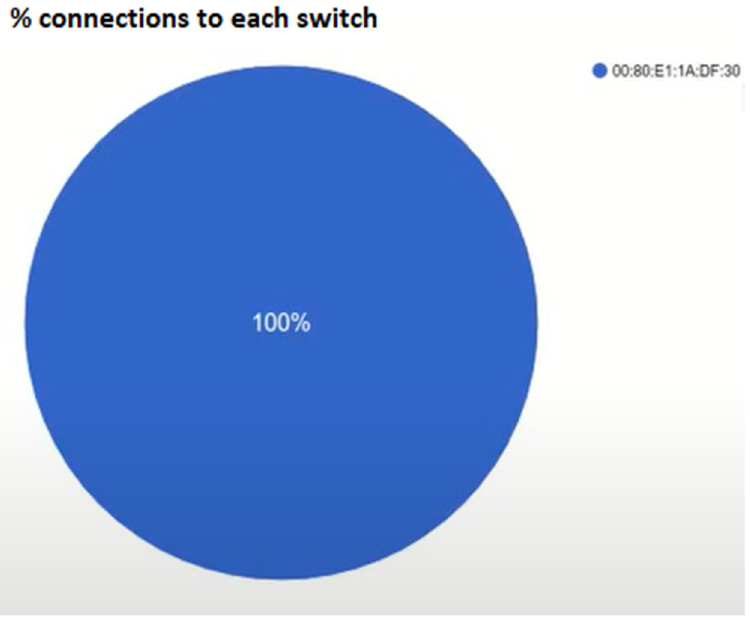
Figure 18. SW3 is directly connected to the concentrator (with MAC address ending in 30).